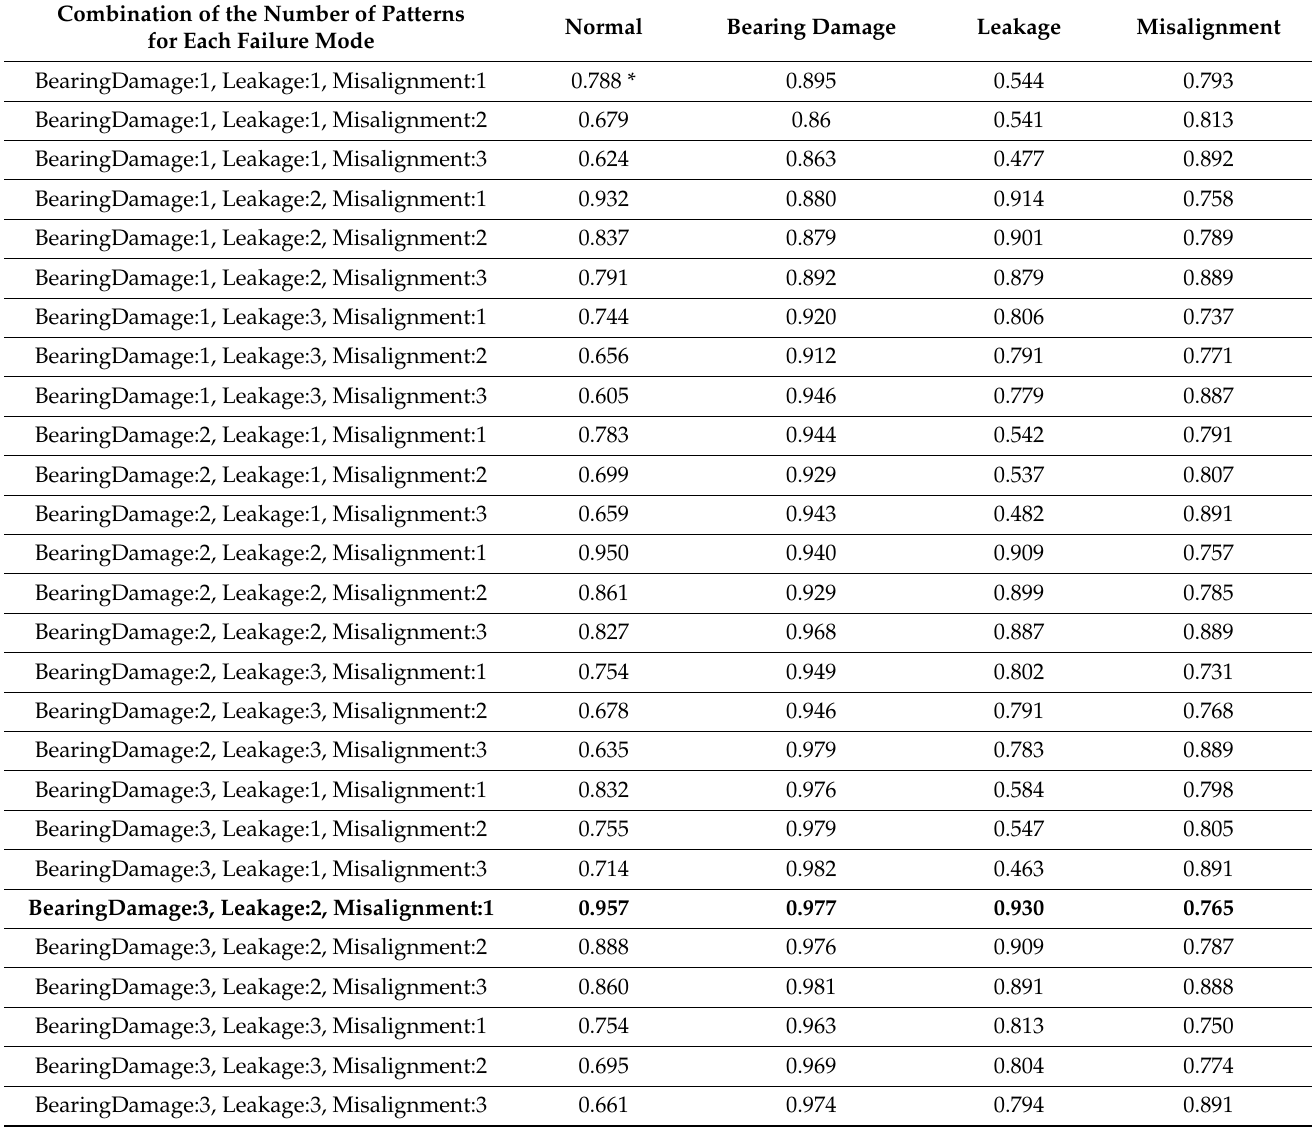
Table 6. Classified results when PF–IFF was